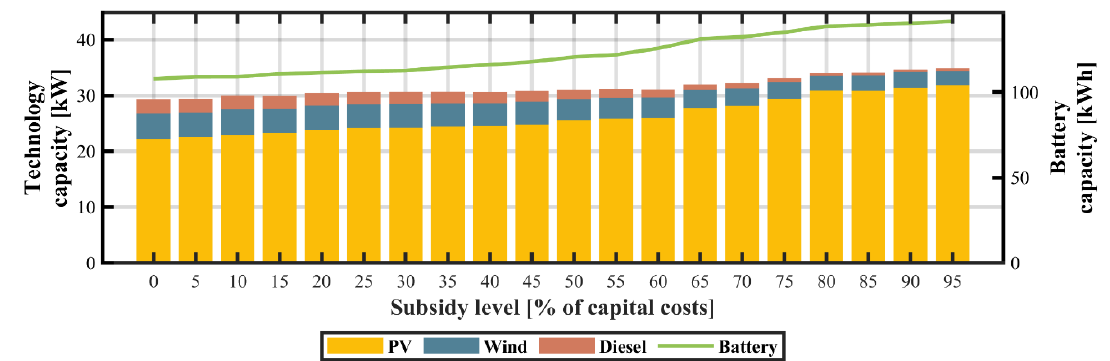
Figure 5. Simulation results of capital subsidies across all DG technologies. Impact on the capacity of DG technologies. Energies 2020 , 13 , x FOR PEER REVIEW